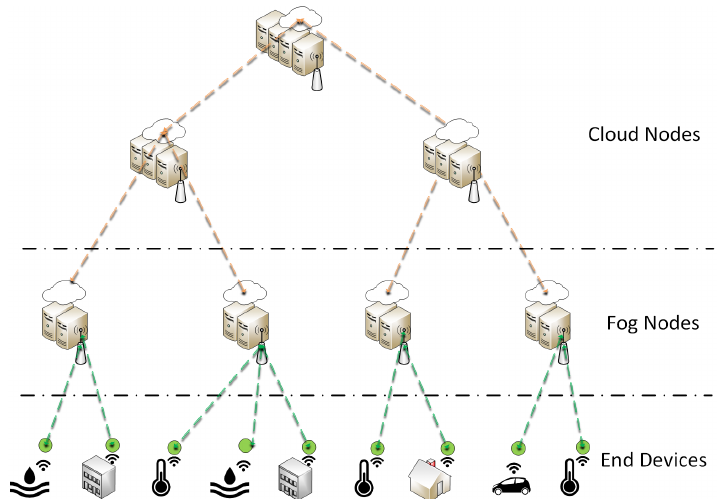
Figure 1. High-level view of Fog